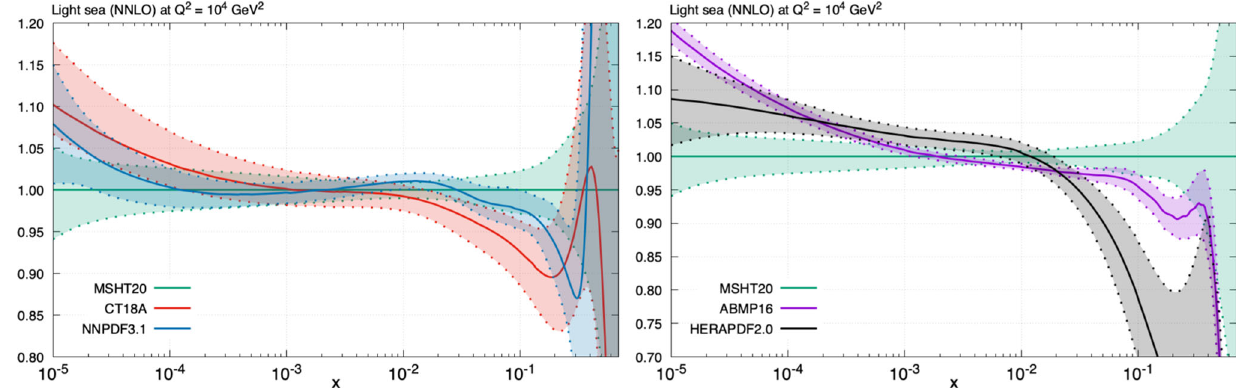
Fig. 90 Comparison of the MSHT20 NNLO light sea PDF at Q 2 = 10 4 GeV 2 with other representative PDF sets, presented as a ratio to the ) = 0 . 118 in all cases MSHT set. These correspond to α S ( M 2 Z